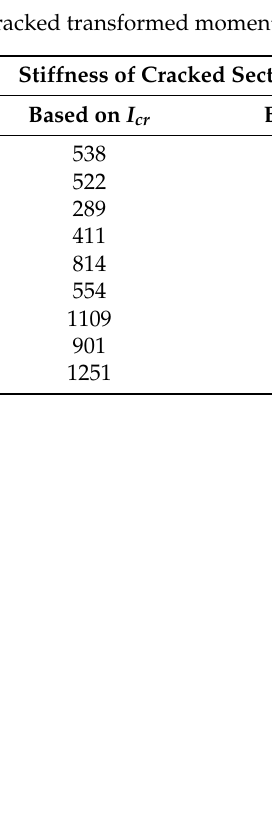
Table 9. Stiffness of cracked sections by effective and cracked transformed moment of inertia.